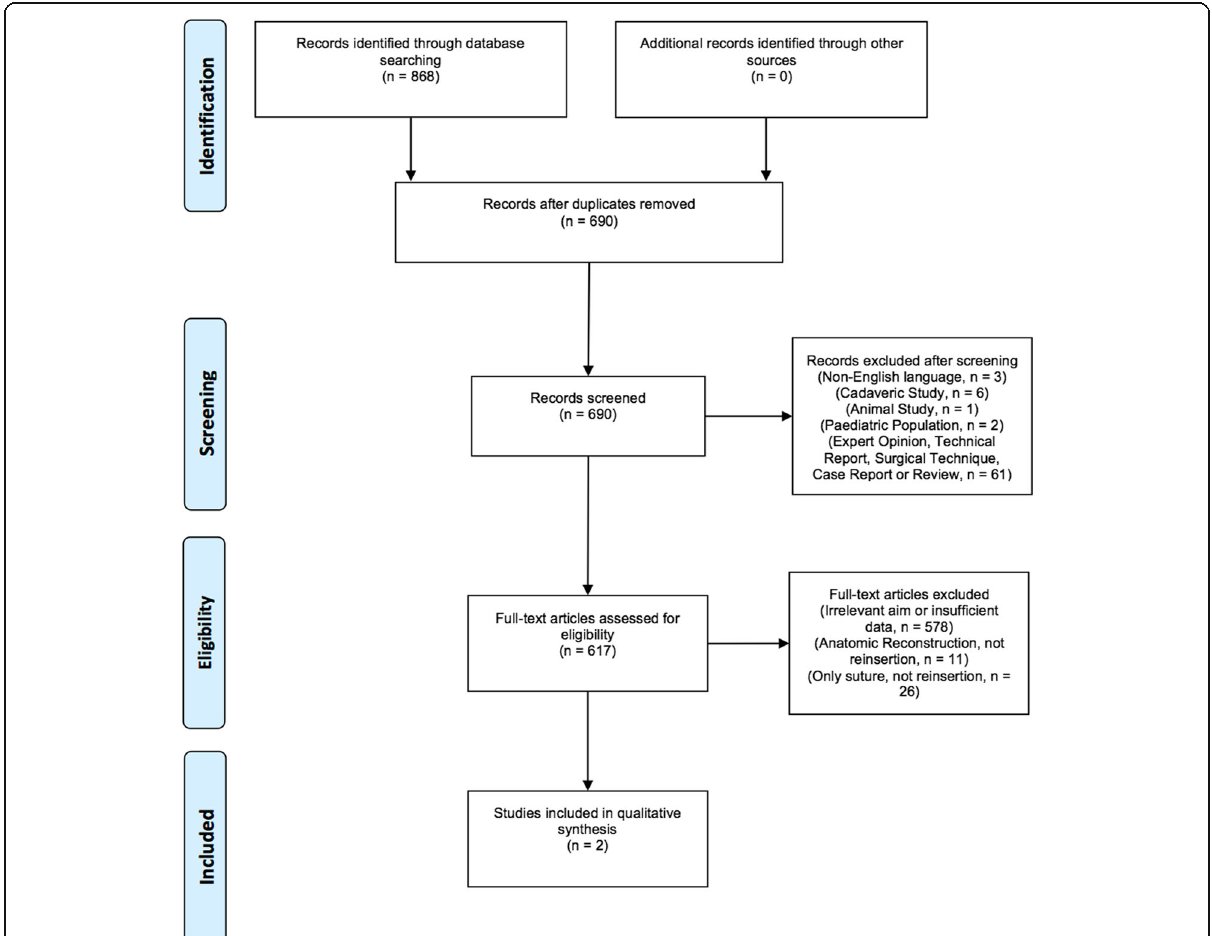
Fig. 4 Flow diagram of inclusion and exclusion after the systematic electronic search performed on May 26, 2016. Complete search strategies including the updated searches on March 21, 2017 and December 27, 2017 are shown in the Appendix. The updated electronic searches performed on March, 2017 and December, 2017 did not generate any new studies eligible for